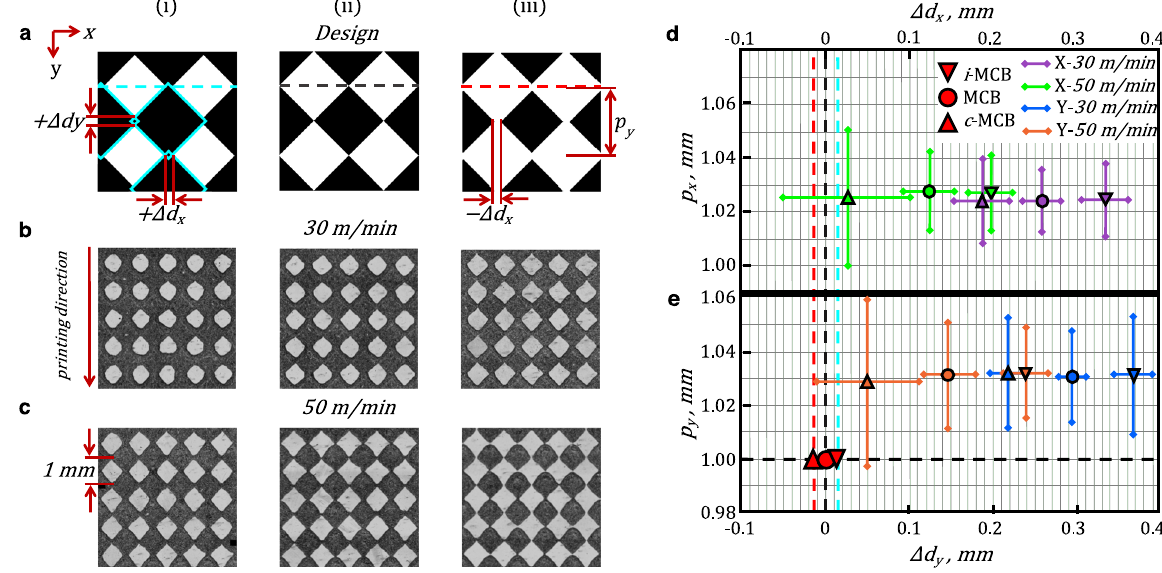
Fig. 1 2D optical microscopy characterization. a Designed samples, where black pixels correspond to ink and white is the substrate (voids): (i) i- MCB pattern with ink stretching of Δ d = + 14 μ m; (ii) is the target MCB pattern for perfect transmission property; (iii) c- MCB pattern with ink compression of Δ d = − 14 μ m. One-quarter of the visible images of the printed patterns obtained with a speed of b 30 m/min and c 50 m/min. d , e Extracted values of lattices and laps/gaps from visible images for X- and Y- directions, respectively. The horizontal and vertical lines show the standard deviation obtained from measuring Δ d and p of fi ve replicas for each structure. The red downward triangle, circle, and upward triangle show the design size of laps or gaps of i- MCB, MCB, and c- MCB, respectively. The dashed lines correspond to the designed dimensions of